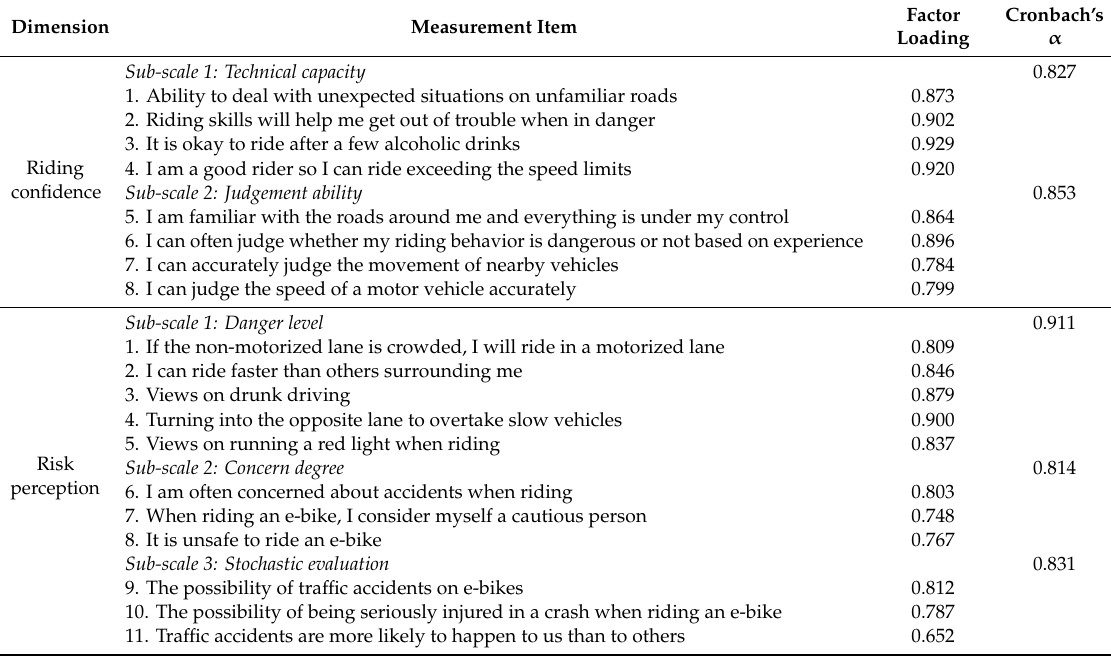
Table A1. Dimension structures of riding confidence, risk perception, safety attitude, and risky riding